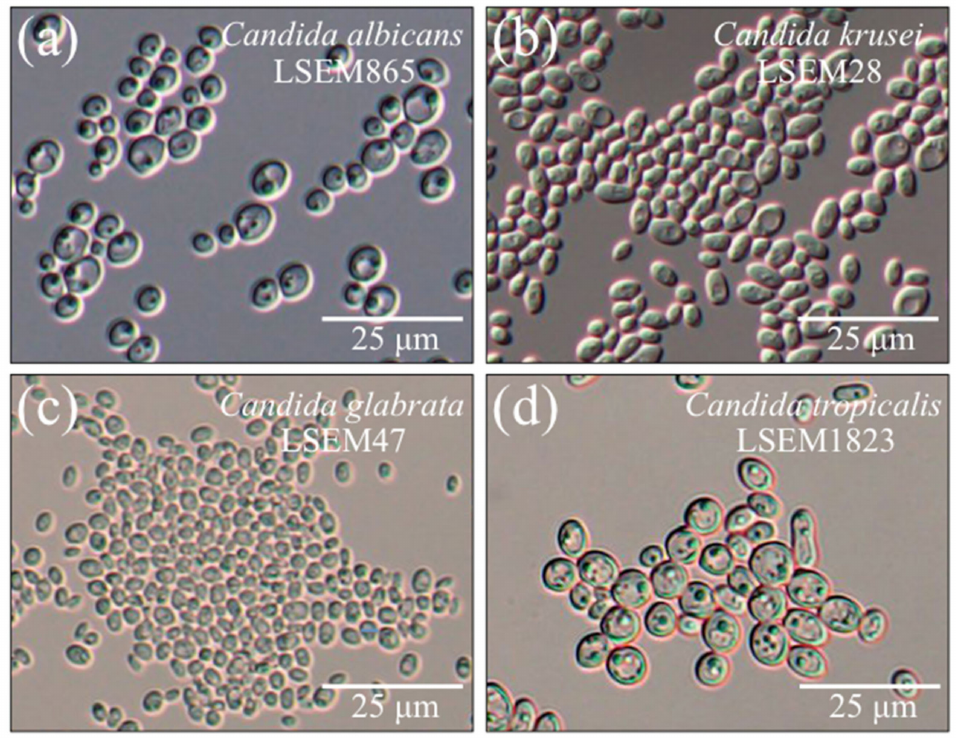
Figure 1. DIC micrographs of ( a ) C. albicans , ( b ) C. krusei , ( c ) C. glabrata , and ( d ) C. tropicalis